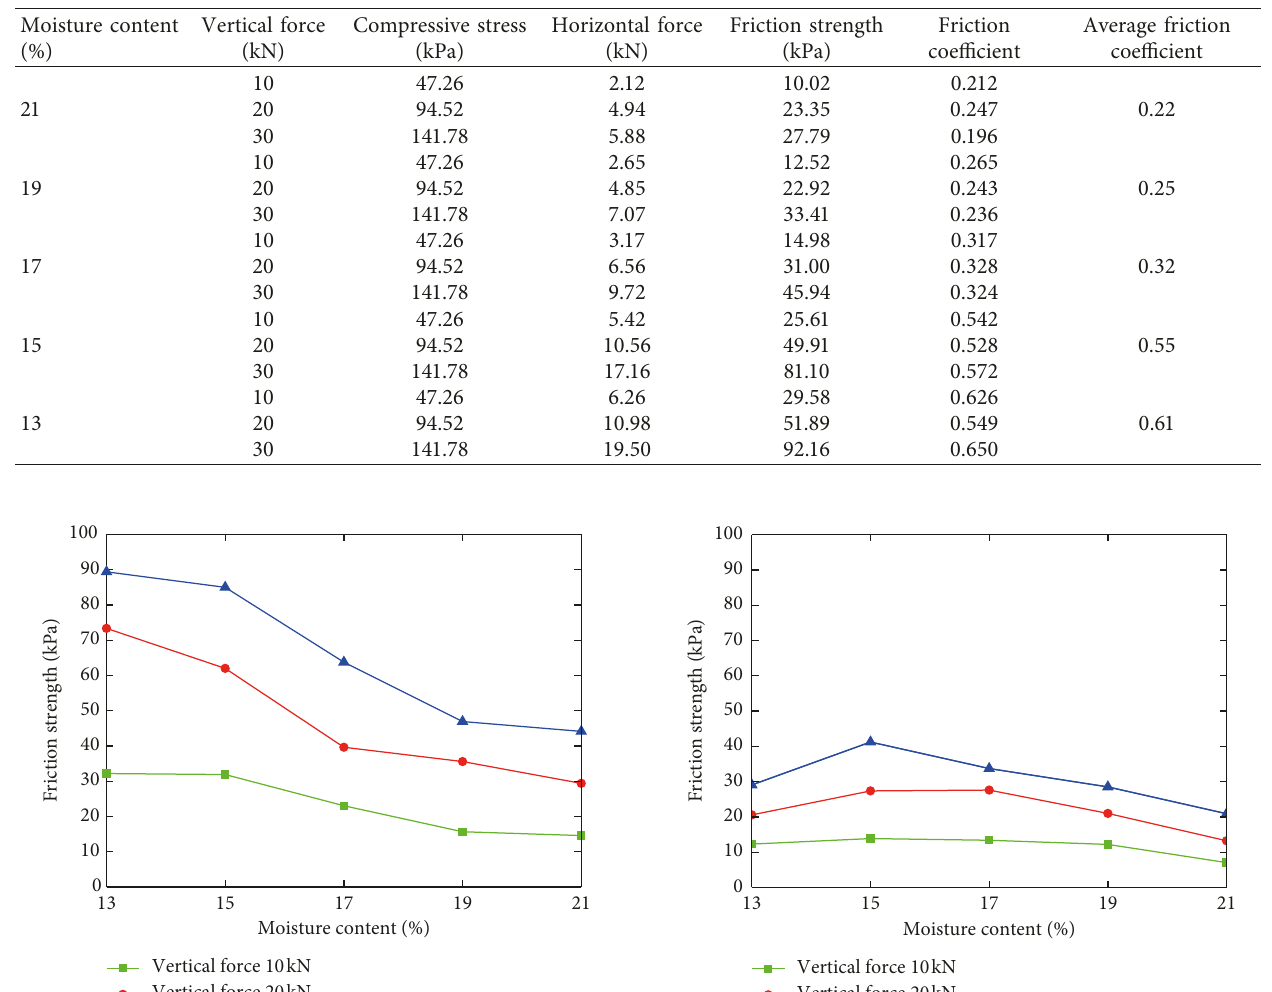
Table 5: Model 4.